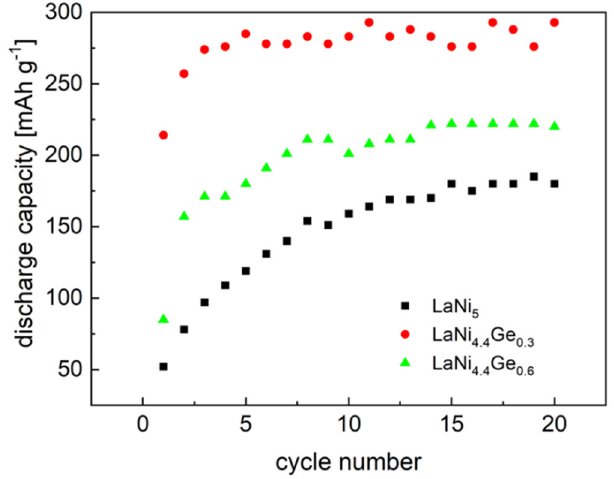
Figure 6. Variation of discharge capacity of the tested composite electrodes for the first 20 cycles. Charge/discharge rate: –185/+185 mA g −1 (6 M KOH, 25 °C).